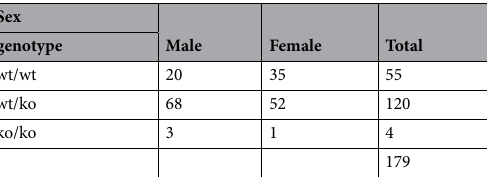
Table 1. The genotype distribution of the pups resulting from heterozygous offspring